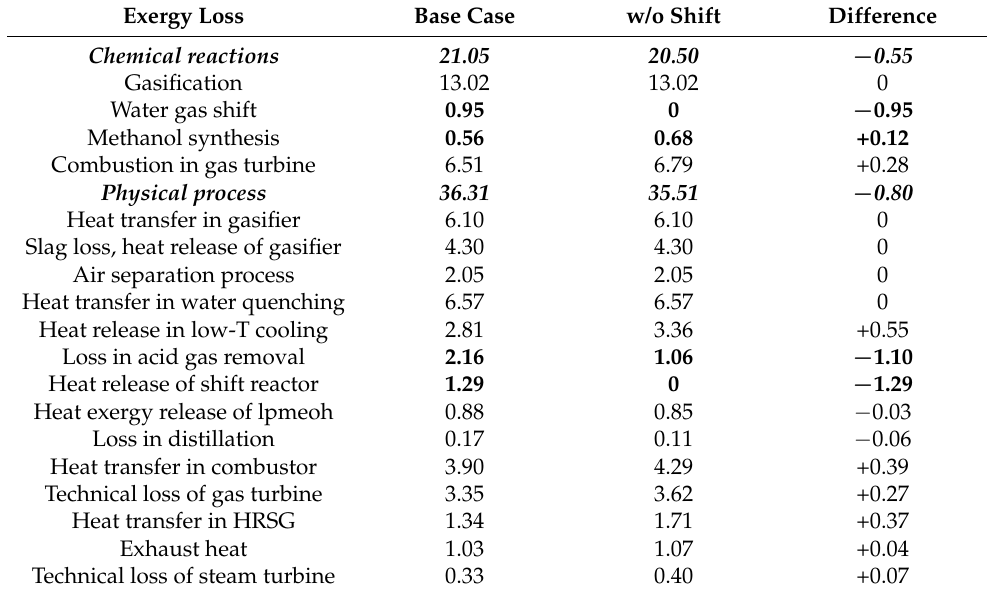
Table 5. Comparison of exergy loss in two once-through series cases (unit: % of total exergy input).